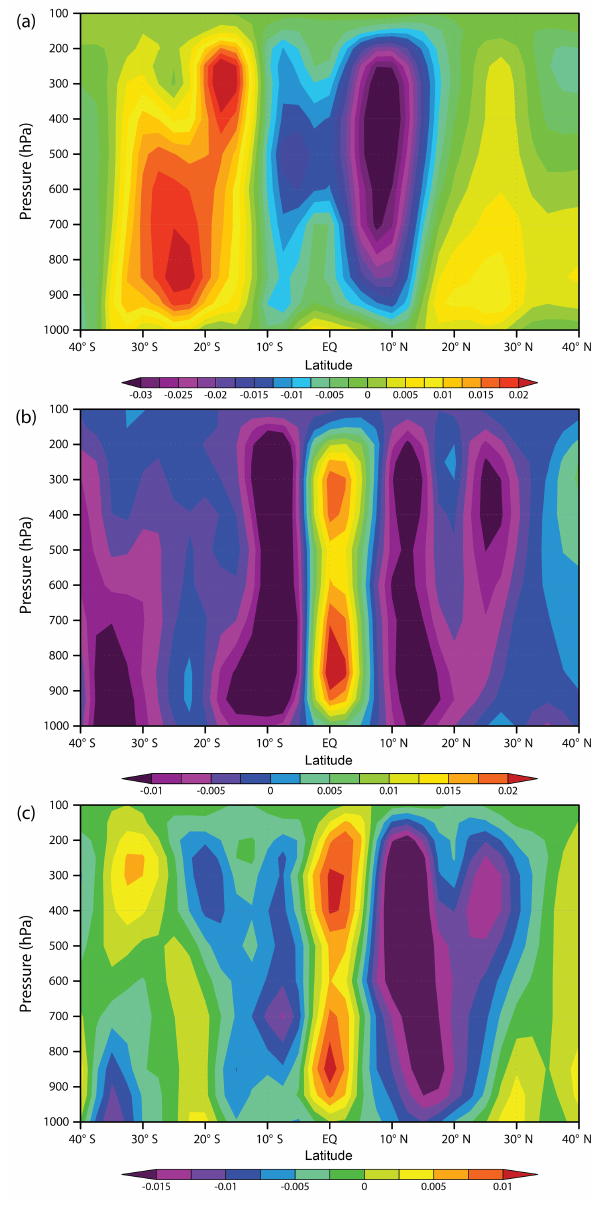
Figure 5. Latitude–height cross section of June to August 120– 240 ◦ E average (a) ω (Pas − 1 ) – vertical velocity in pressure coordi- nates – for 1979–2016, (b) ω difference of 2016 minus 1979–2016, and (c) ω difference of 2016 minus